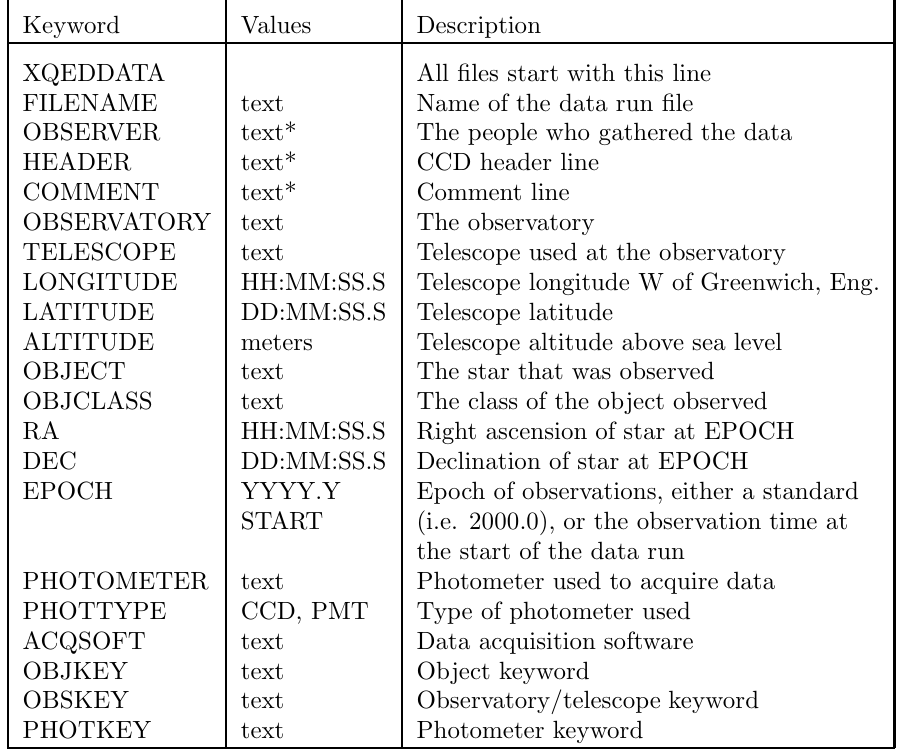
Table 2. Header keywords. Note that values marked with a star can occur on multiple lines in the header